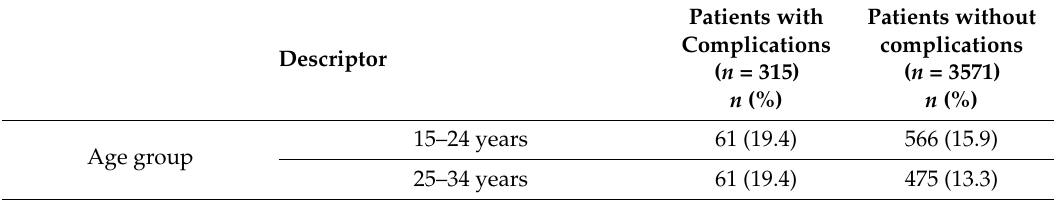
Table 3. Characteristics of patients with and without fracture healing complications ( n =